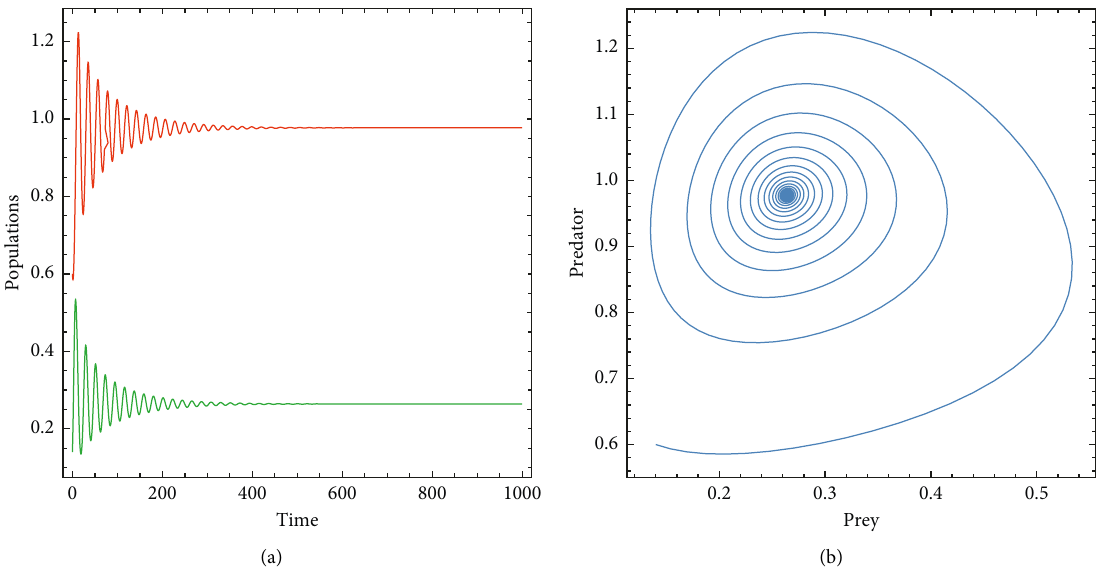
Figure 2: Locally asymptotically stable. (a) Time plot; (b) phase portrait for the model (51) with m